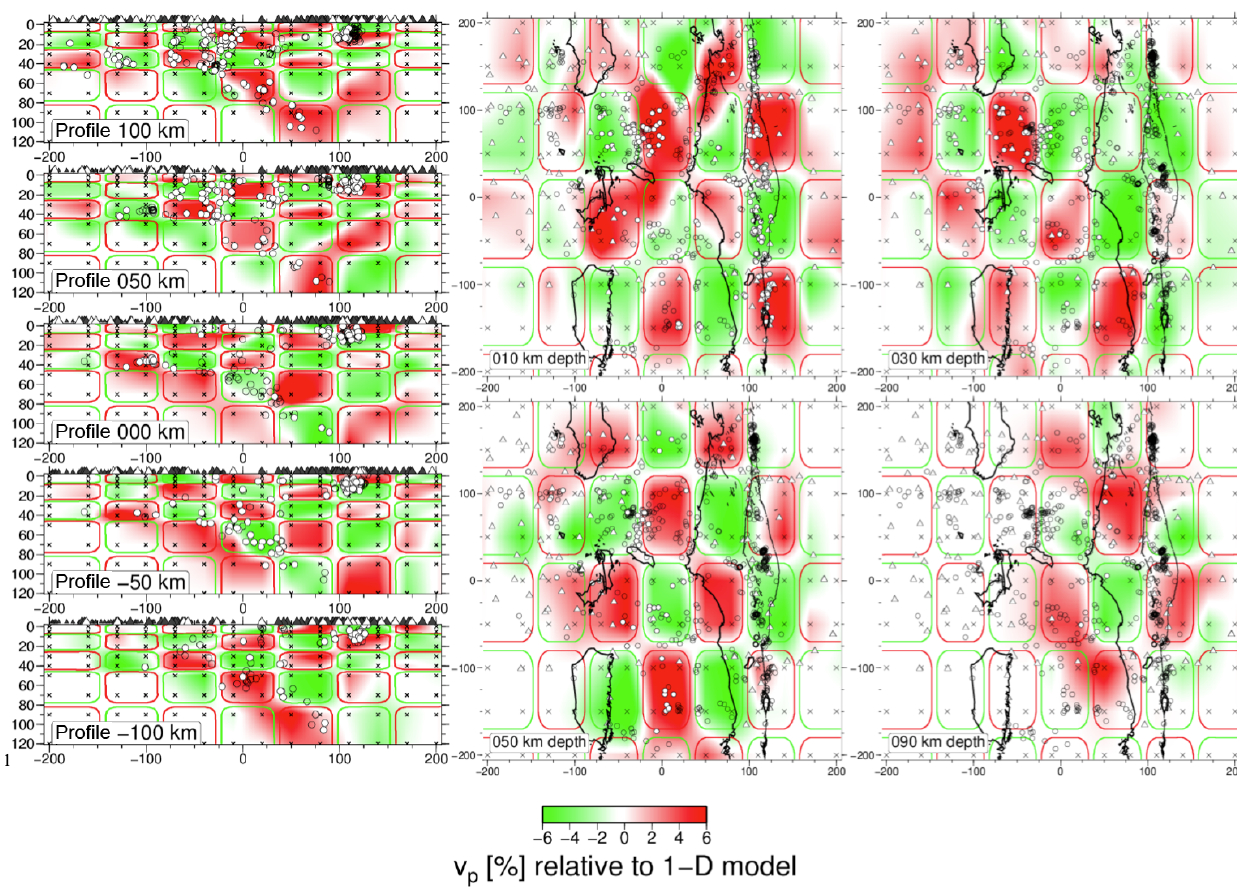
Figure 6. 3-D synthetic checkerboard models with 5% velocity perturbation input anomalies and the inversion restoration for the 3-D v p model. Other symbols as in Fig.